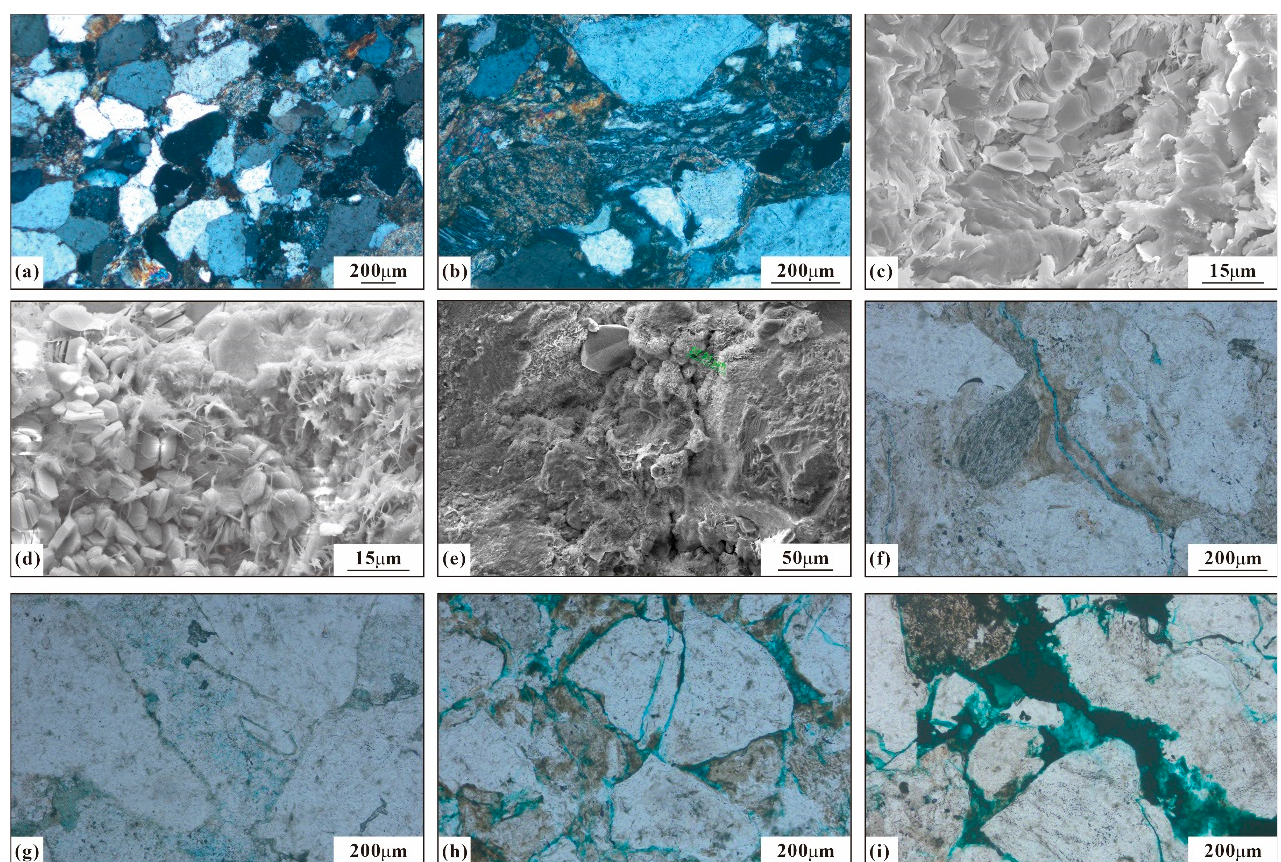
Figure 4. Thin sections and scanning electron microscopy (SEM) images showing the microscopic characteristics of reservoir space and fillings of tight sandstones in the Lower Shihezi Formation in the Duguijiahan block, Ordos Basin: ( a ) well J57, 2996.3 m, clastic particles are closely arranged in line contact, ppl; ( b ) well J95, 3203.7 m, rock fragment of schist, cpl; ( c ) well J100, 2927.2 m, the particles are filled with authigenic kaolinite and illite, SEM; ( d ) well J103, 3076.89 m, clastic particles are filled with filamentous illite and flaked kaolinite, micropores of some fillings are interconnected, SEM; ( e ) well J96, 3062.3 m, clastic particles are wrapped by chlorite films, and the edge of particles is dissolved, SEM; ( f ) well J108, 3143.7 m, dissolution microcrack, ppl; ( g ) well J110, 3030.5 m, intergranular micropores in vermiculite-like kaolinite, ppl; ( h ) well J112, 3130.5 m, intergranular pores are communicated by lamellar throat, ppl; and ( i ) well J126, 2917 m, intergranular pore and intergranular dissolved pore, ppl. Abbreviations: ppl: plane-polarized light; cpl: cross-polarized